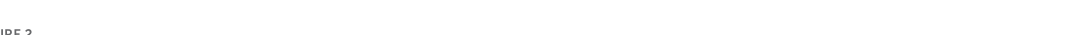
FIGURE2 Representative images of immunofluorescence double staining (D) and quantitative analysis (E) of the cross-sections of adductor muscles 7 days after the surgery. The ratio of Ki67-positive cells to SMCs in each field was quantified. Red, Ki67. Green, α -SMA. Blue, 4’,6-diamidino-2-phenylindole (DAPI). (F,G) Representative images (F) and a quantitative analysis (G) of HE staining and immunohistochemistry of α -SMA in cross-sections of the adductor muscles from PBS-, Sed-Exo- and Exe-Exo- treated rats 7 days after surgery. (H–J) Representative images (H) and a quantitative analysis (I,J) of immunofluorescence double staining and CD31 immunohistochemistry in cross-sections of the gastrocnemius muscles from PBS-, Sed-Exo- and Exe-Exo- treated rats 7 days after surgery. The ratio of Ki67-positive cells to total ECs in each field was quantified. Red, Ki67. Green, CD31. Blue, DAPI. Arrows, representative Ki67 positive SMCs. N = 6 per group. ** P < 0.01, *** P < 0.001. FAL indicates femoral artery ligation. Scale bar = 20 or 50 µ m as presented in the above images. Data are means ±